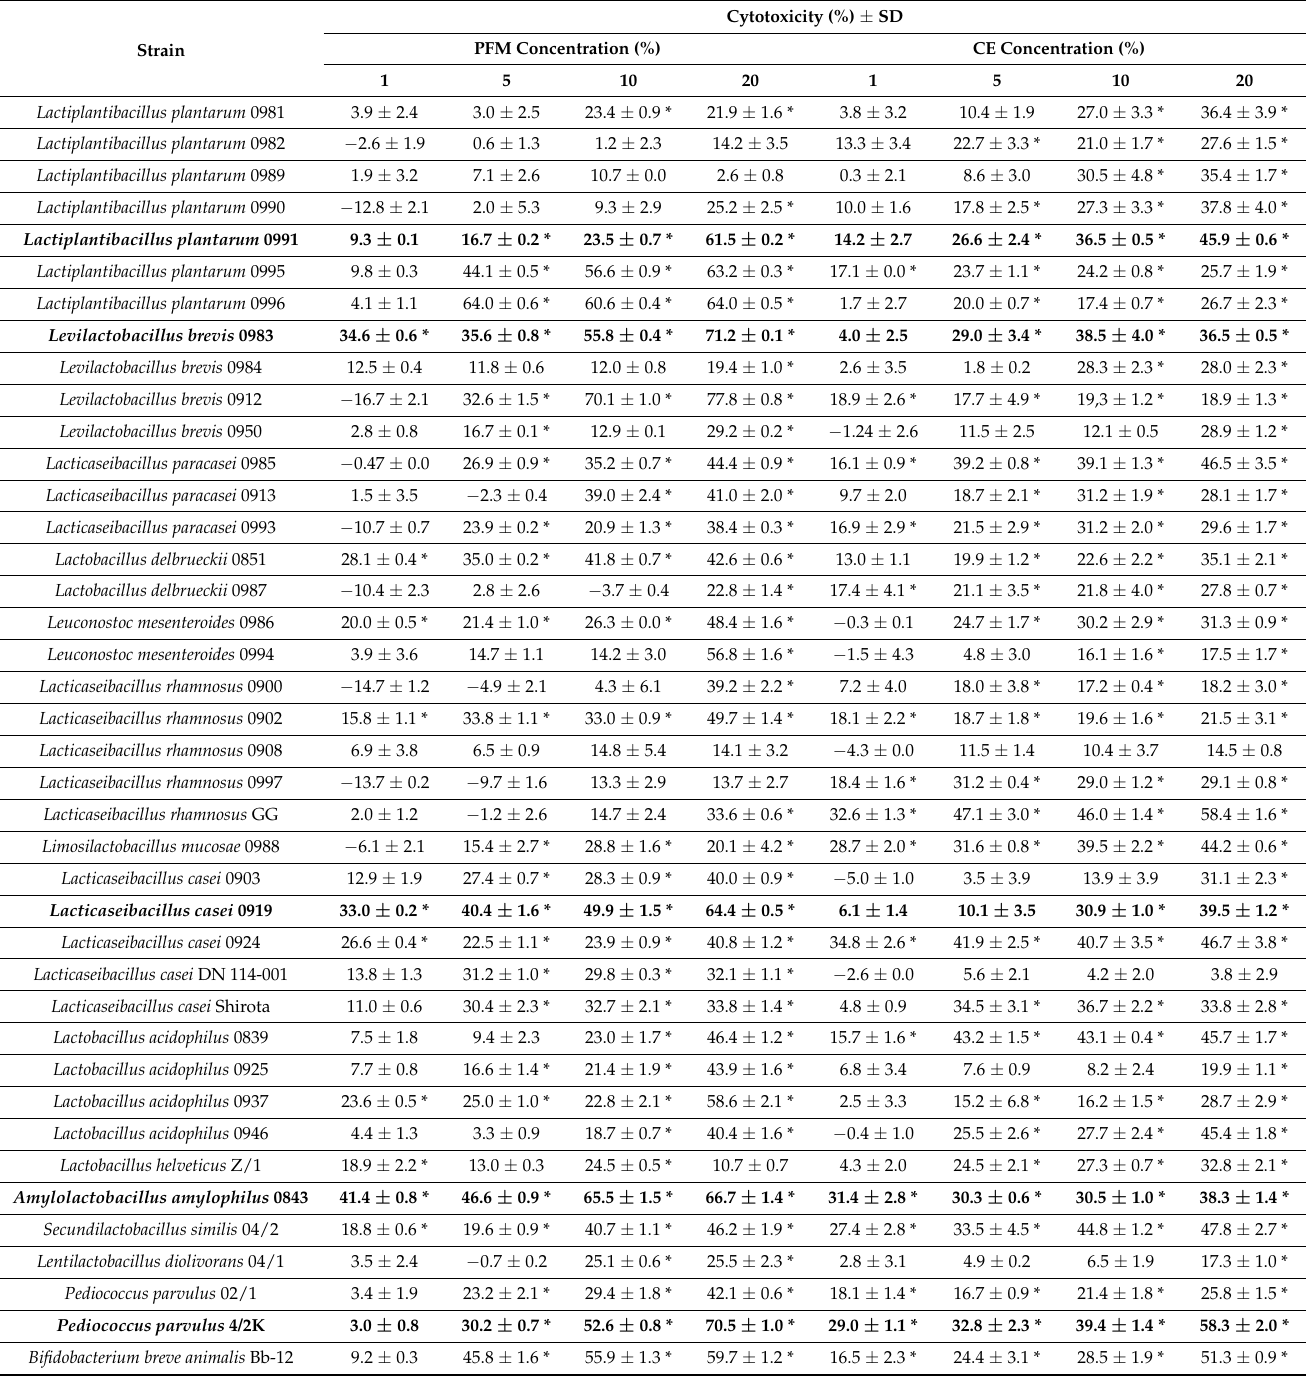
Table 1. Antiproliferative and cytotoxic activity of post-fermentation media (PFM) and cell extracts (CEs) as determined by 3-(4,5-dimethylthiazol-2-yl)-2,5-diphenyltetrazolium bromide (MTT) assay in the Caco-2 cell line after 48 h exposition. Each data point represents the mean ± SD, n ≥ 4. * Result significantly different from untreated control cells, p ≤ 0.05. The strains with the strongest antiproliferative activity selected for further studies are